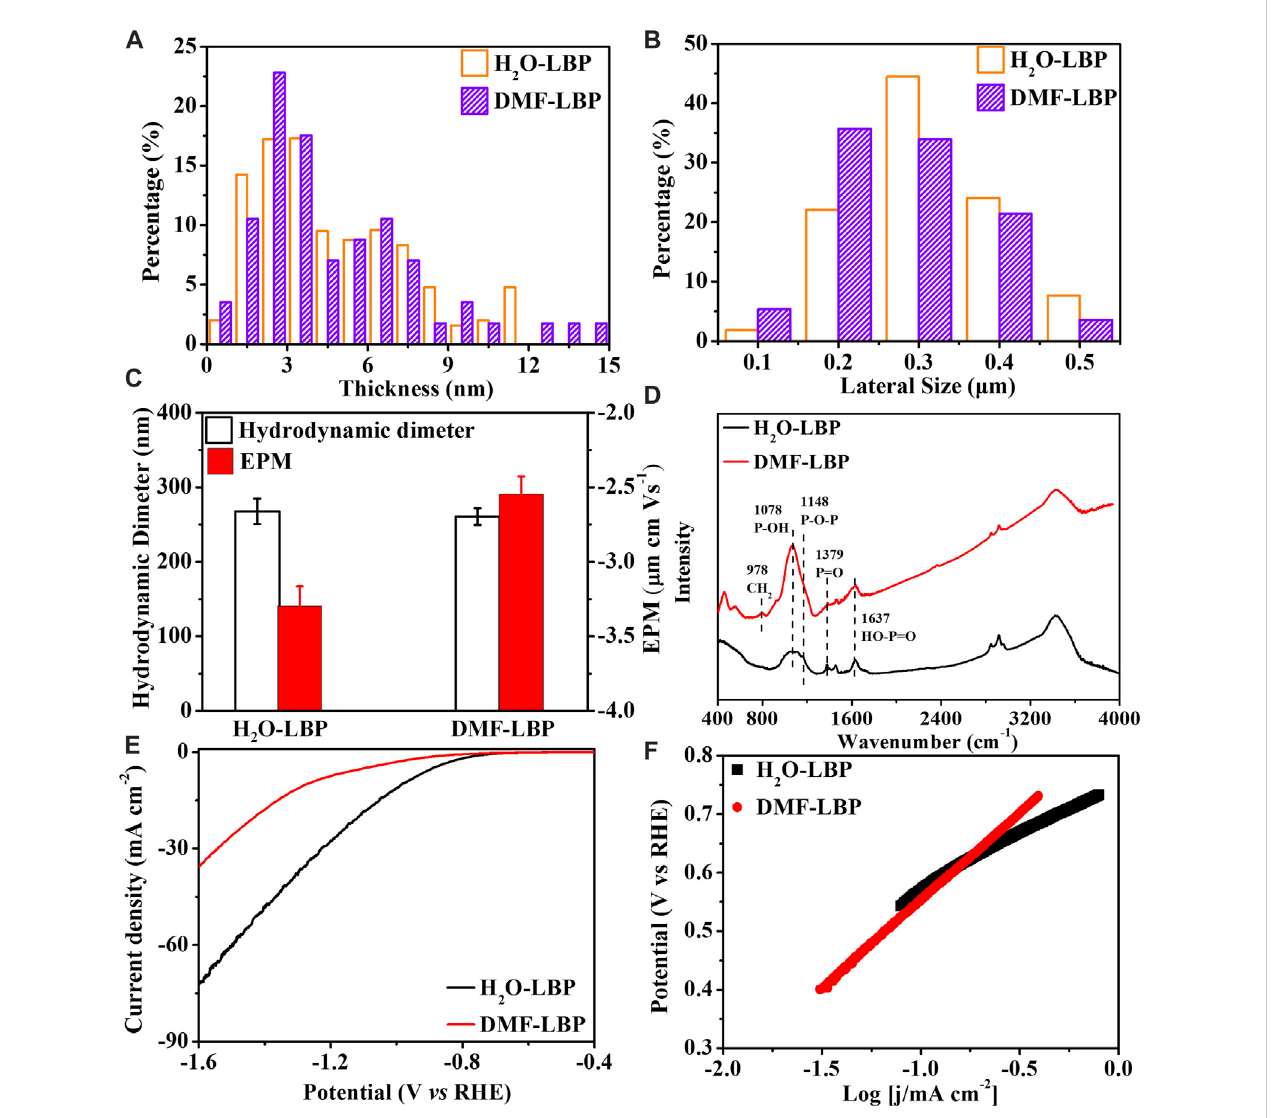
CharacterizationsofLBP.Thicknesses (A) andlateralsizes (B) oftwotypesofLBPnano fl akes (C) HydrodynamicdiametersandEPMoftwotypesofLBPat pH 7 (D) FTIR spectra of two types of LBP; Polarization curves (E) and Tafel plots (F) of both LBP in N 2 -saturated 0.5 mol L − 1 H 2 SO 4